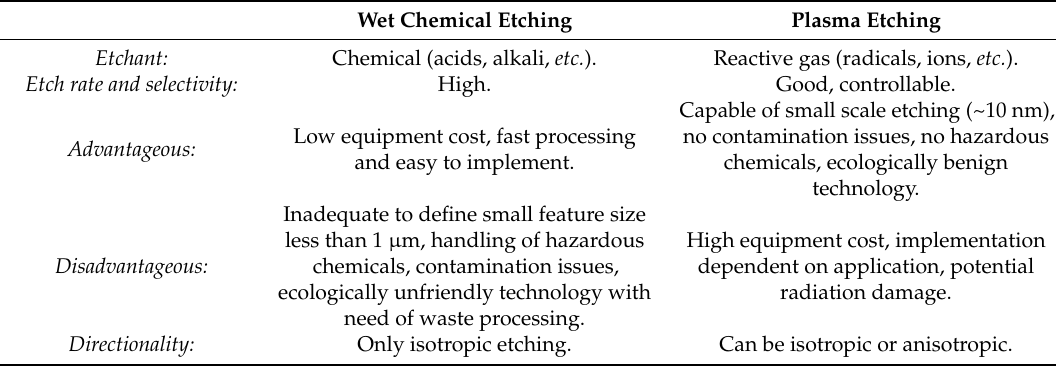
Table 1. Comparison of wet chemical etching versus plasma